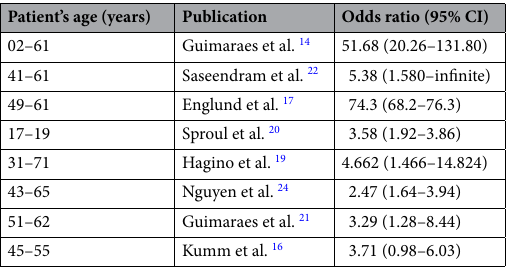
Table 3. Age-related odds ratios for patient morbidity.